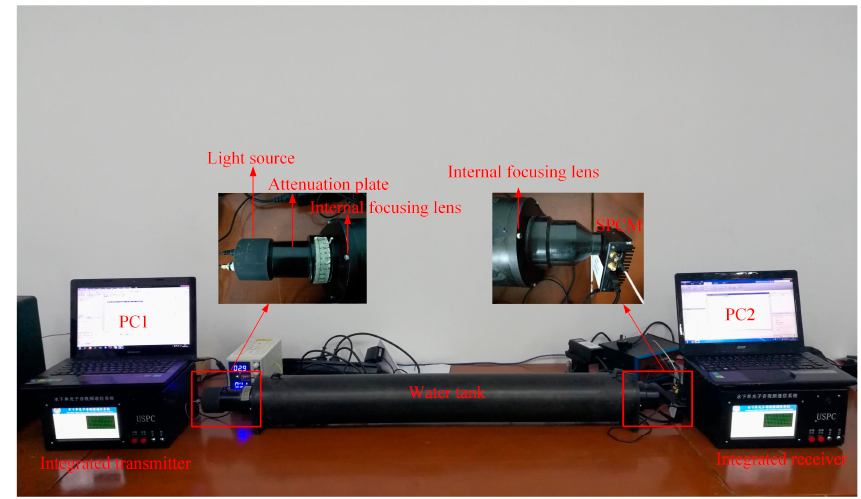
Figure 5. Photon-counting underwater optical wireless communication system.